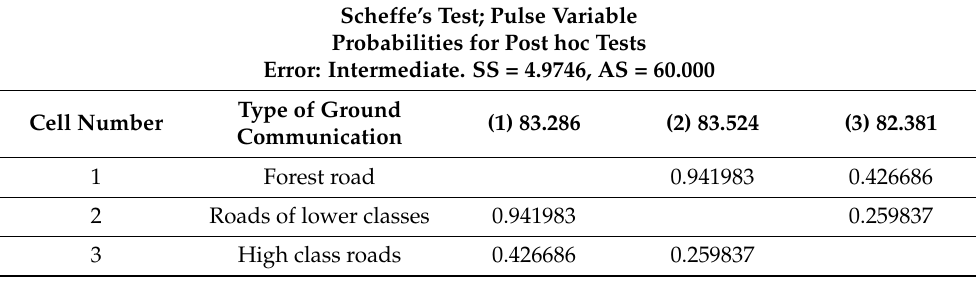
Table 10. Post hoc test to analyze the variance of heart rate values depending on the type of communication when driving the passenger